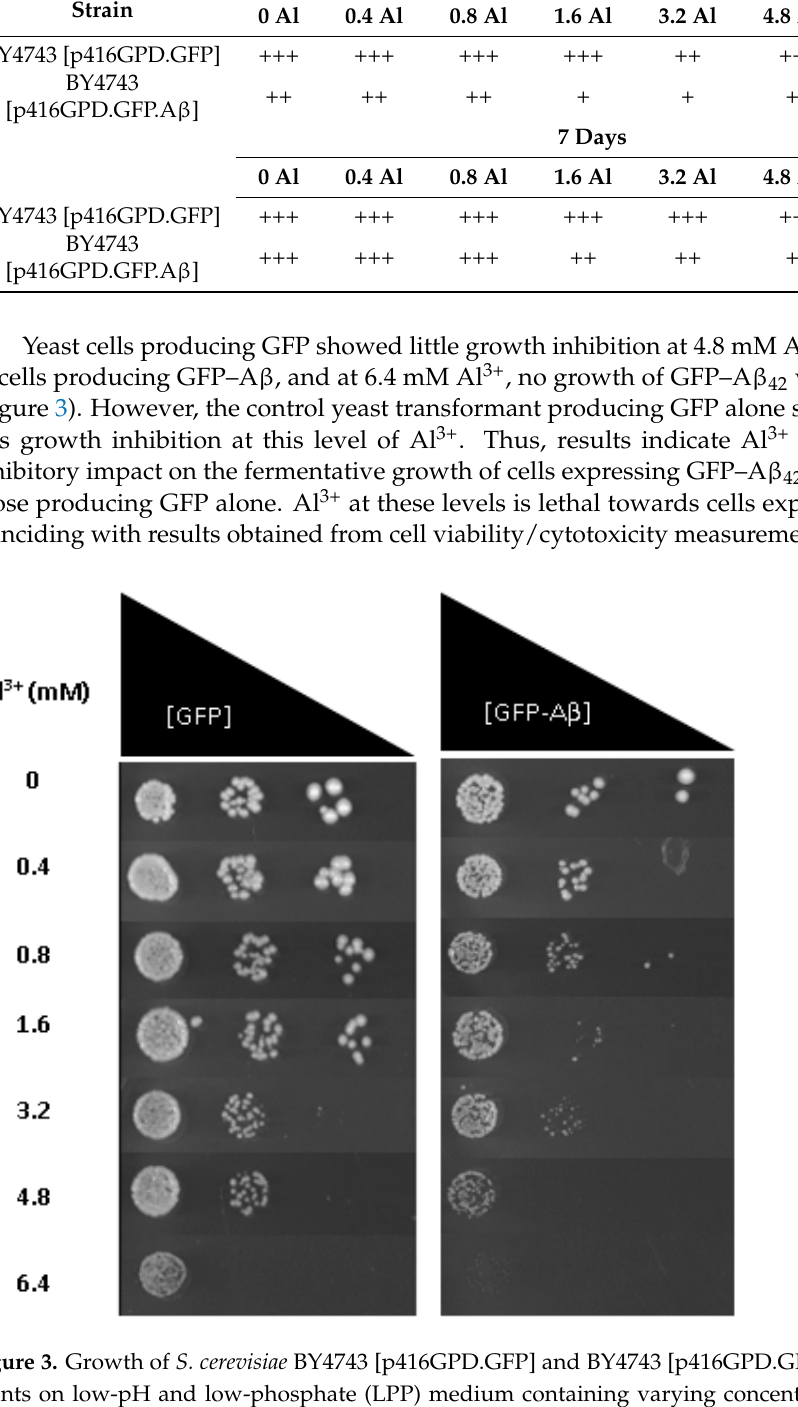
Table 1. Growth of S. cerevisiae transformants in the presence of varying concentrations of Al 3+ . Transformant Yeast Strain